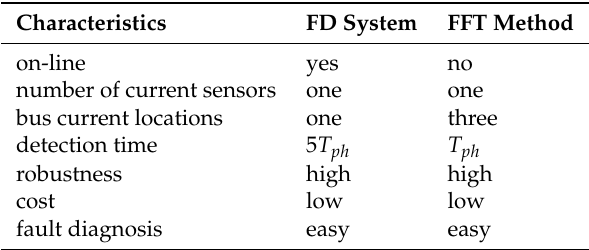
Table 4. Comparison of fault detection